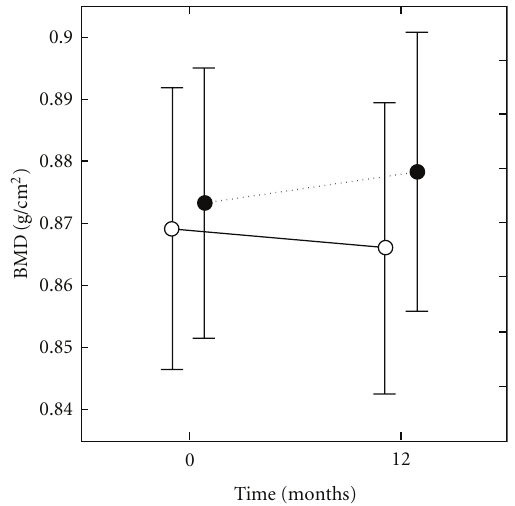
Figure 4: Evolution of hip BMD in a group of osteoporotic postmenopausal women randomized into a fast walking program (filled circles, n = 48), compared to 44 controls (open circles). The slight di ff erence at one year was significant ( P = . 04). Reproduced from Bergstr¨om et al. Osteoporos Int 2008; 19: 177-83 [169], with kind permission of